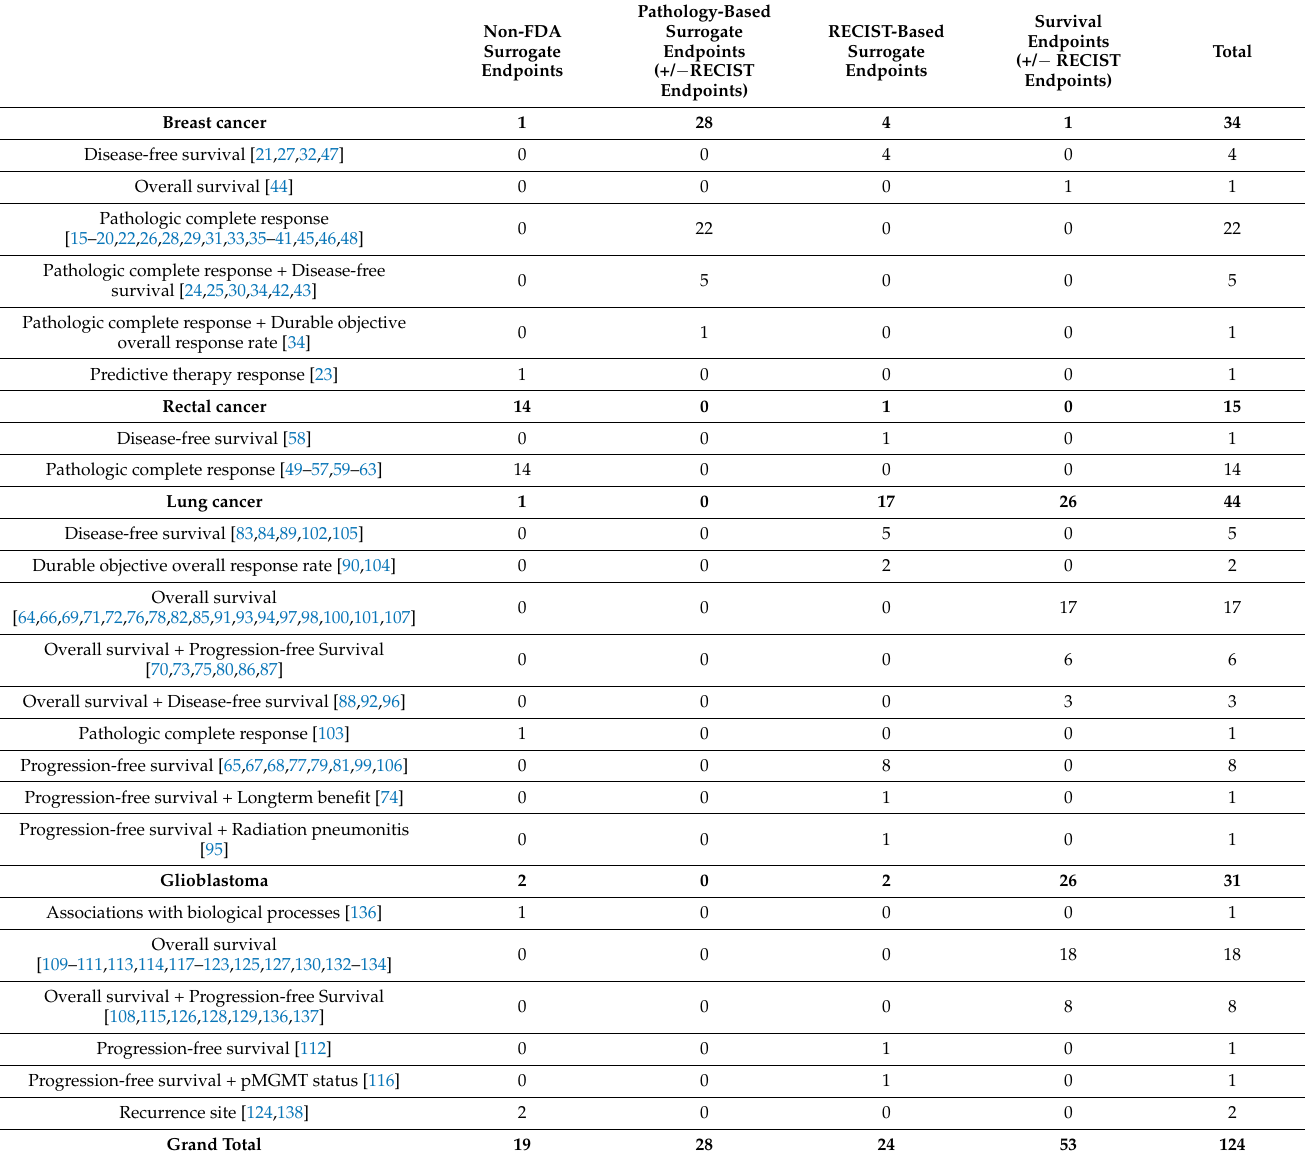
Table 2. Summary of primary endpoints. Classification of surrogate endpoints is based on definitions from FDA’s surrogate endpoint table